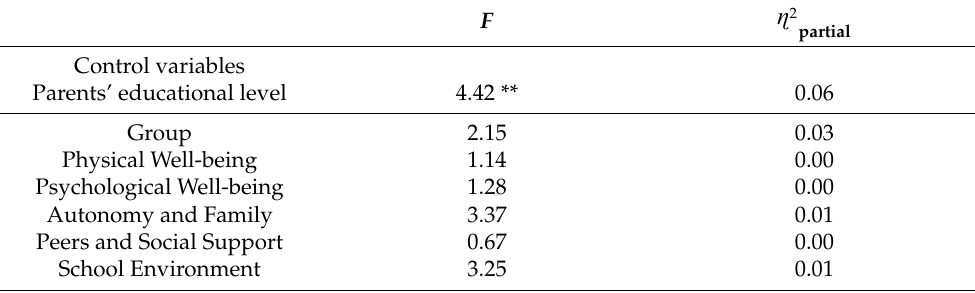
Table 5. Differences in QoL between control and intervention groups ( N CG = 221; N IG = 132).